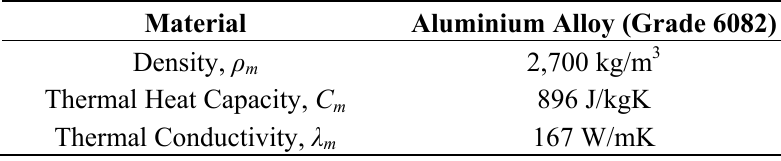
Table 3. Properties of the material used in the infrared thermography